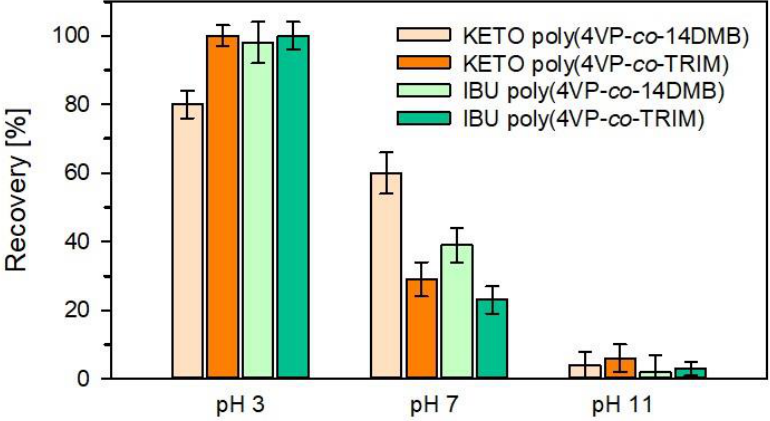
Figure 8. Recoveries obtained for ketoprofen and ibuprofen on 4VP copolymers from solutions of pH = 3, 7, 11; (mean (bar) ± standard deviation (whisker) ( n = pH = 3, 7, 11; (mean (bar) ± standard deviation (whisker) ( n = 3)).